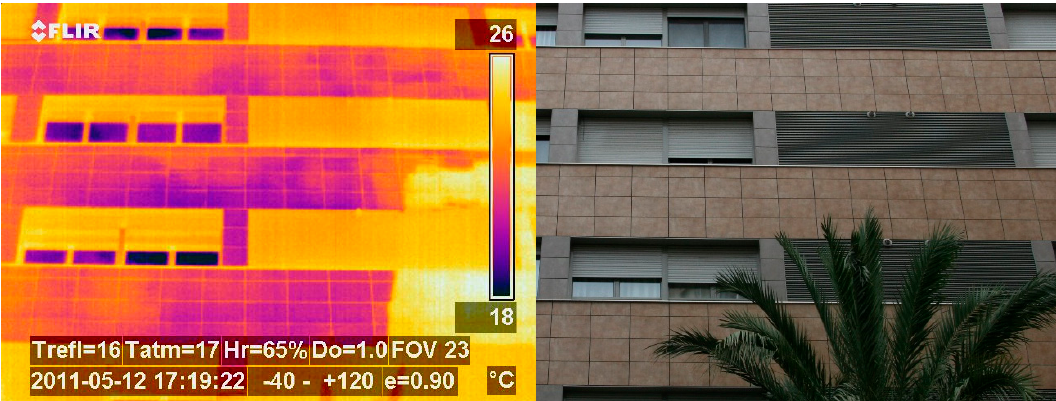
Figure 14. The thermographic image of the northwest facade. Taken on 12 May 2013, at 3:55 p.m.